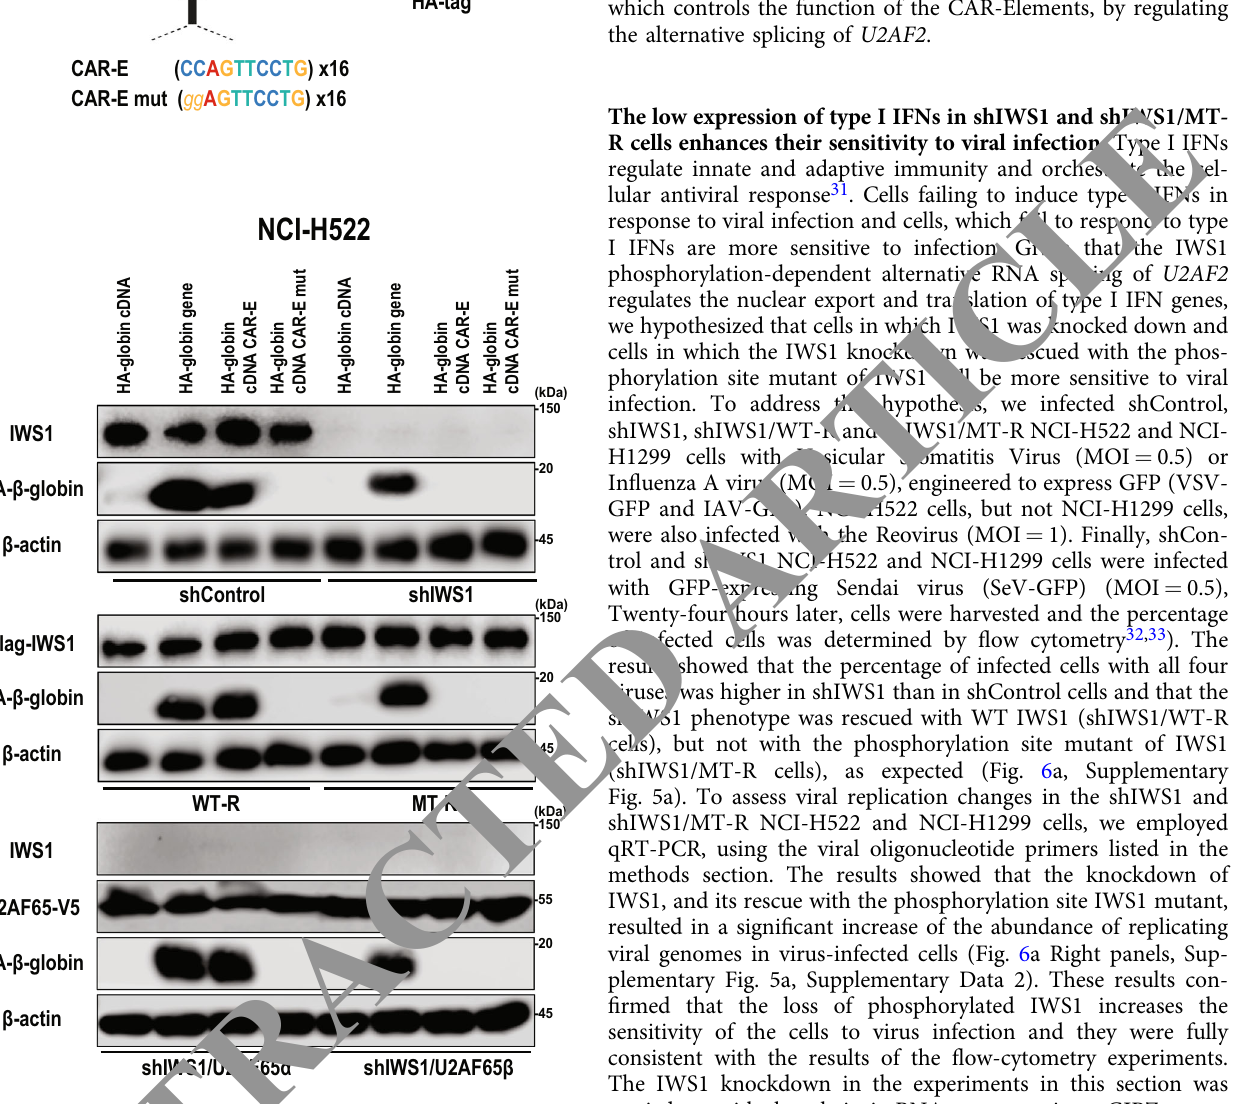
Fig. 5 The RNA nuclear export function of the cytoplasmic accumulation region elements (CAR-Elements) is under the control of IWS1 phosphorylation and the alternative RNA splicing of U2AF2 . a Schematic of the pCMV-HA- β -globin cDNA construct . The sequences of the CAR-E and CAR-E mut are shown and the map position of their insertion is indicated with a solid arrow 4 . The transcription initiation site, the translation initiation codon (ATG), the HA epitope tag, the bovine growth hormone (BGH) polyA signal (pA) and the sizes of the exons in base pairs are also shown. The schematic for β -globin CAR-E reporter was created with Biorender.com under the third-party publication license permission OO22MW9YPA. b IWS1 phosphorylation is required for CAR-E function . shControl, shIWS1, shIWS1/WT-R, shIWS1/MT-R, shIWS1/U2AF65 α -R and shIWS1/ U2AF65 β -R NCI-H522 cells, were transfected transiently with pCMV- based constructs of HA- β -globin cDNA, HA- β -globin Gene, HA- β -globin cDNA-CAR-E and HA- β -globin cDNA-CAR-E mut . Transfected cells were harvested 48 h later, and their lysates were probed with the indicated